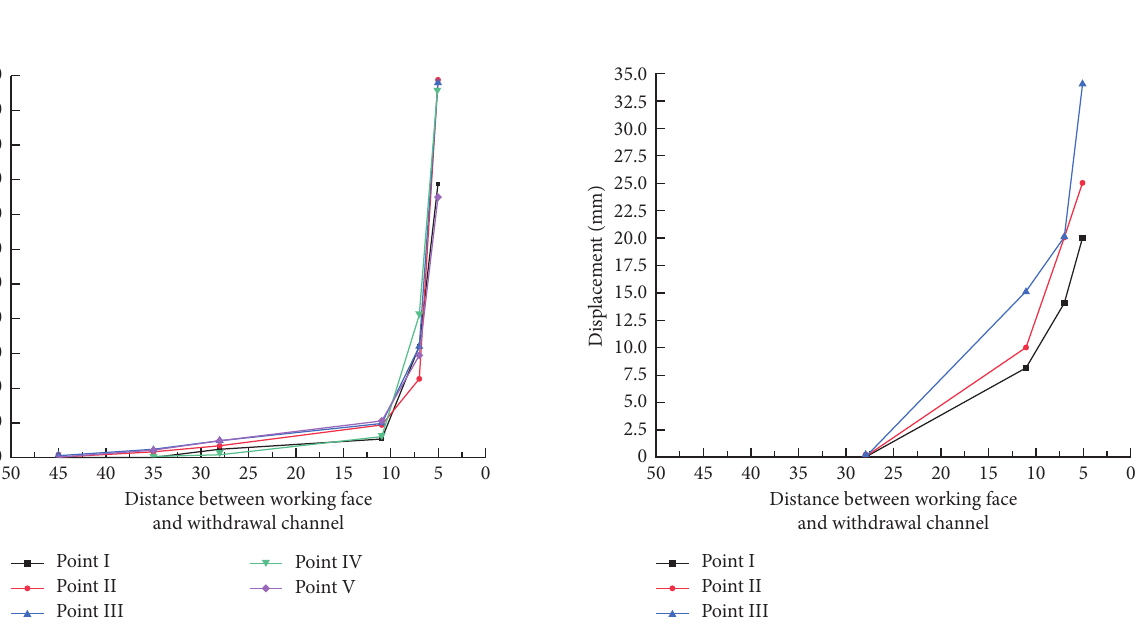
Figure 23: Displacement variations between ribs of main with- drawal channel.